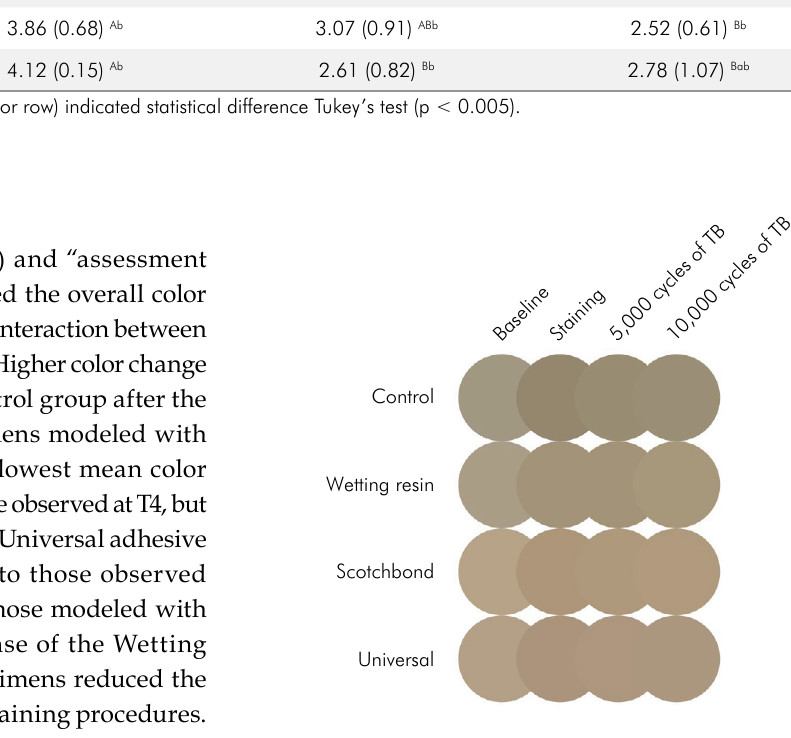
E00 values from baseline data according to treatment and assessment time intervalsa. Δ